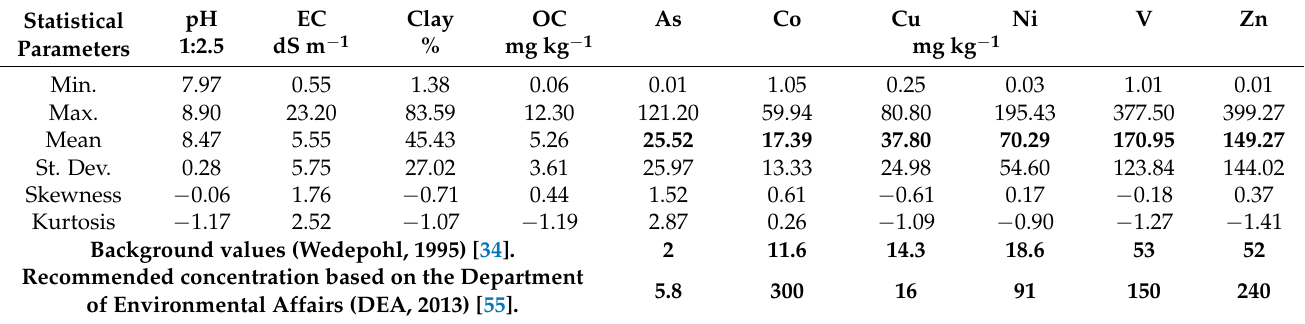
Table 1. Statistical analysis of selected heavy metals and soil properties (n = 61).